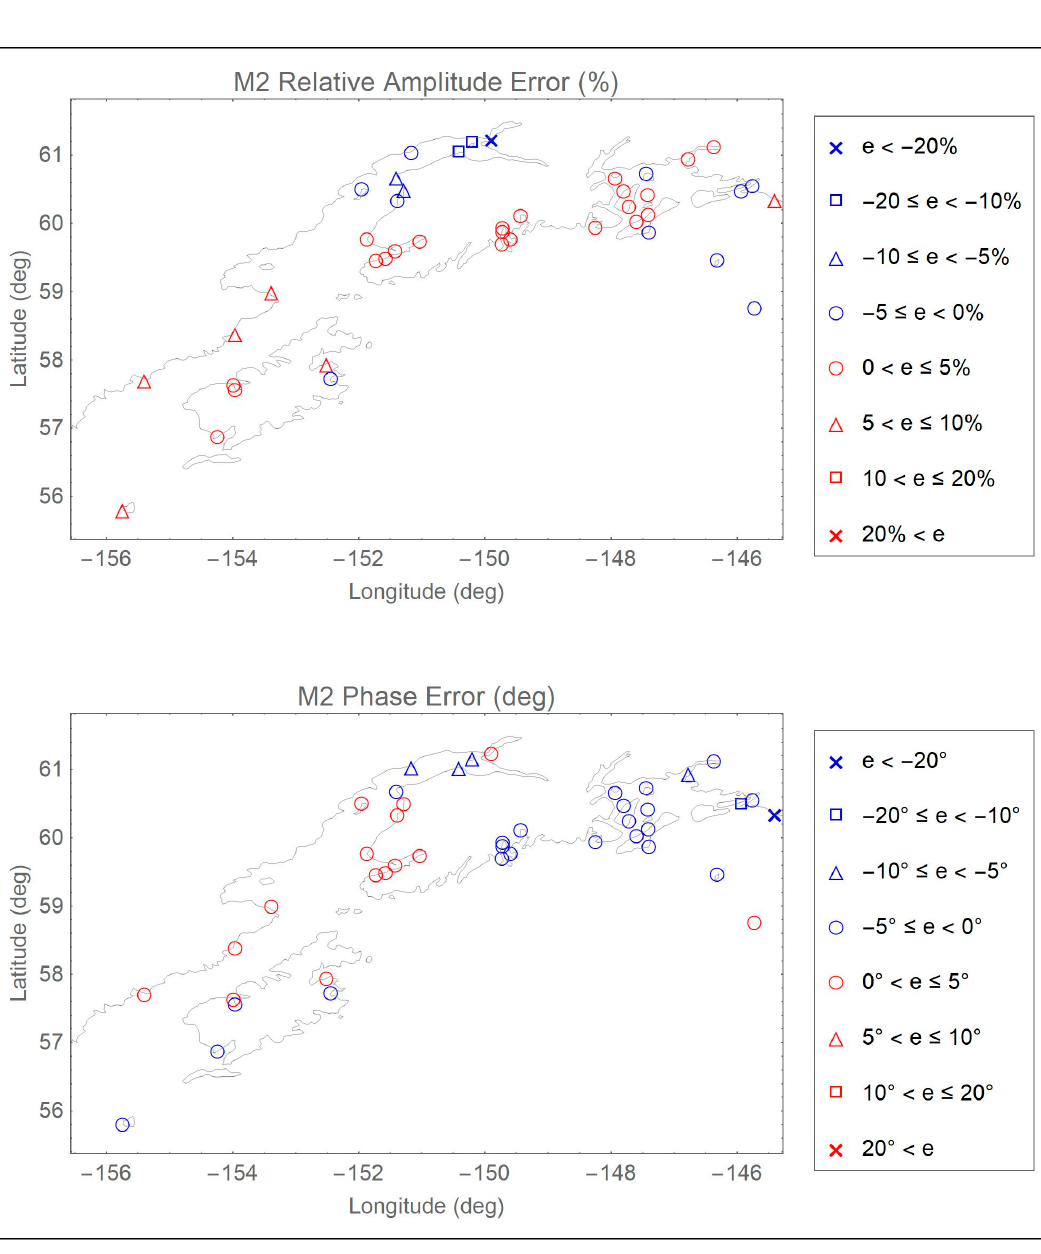
Figure A24. Distribution of ENPAC15 relative amplitude (%) and absolute phase (deg) errors for the M 2 constituent: Southern Alaska coast view one.